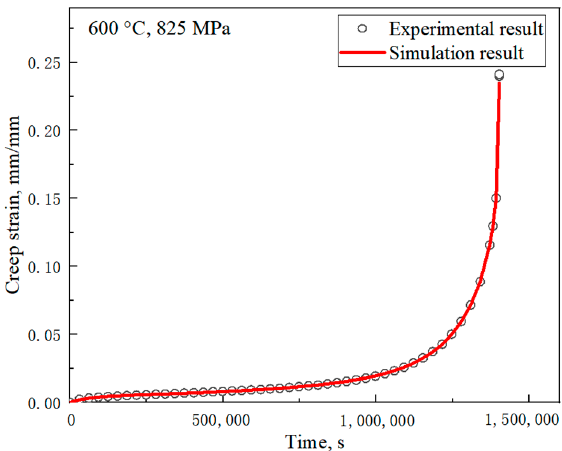
Figure 13. Simulation result of the creep test at 600 °C and 865 MPa.